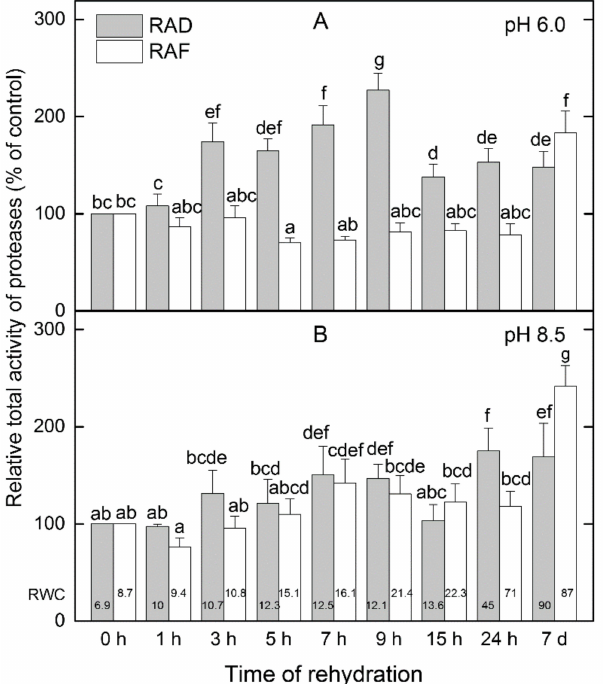
Figure 8. Relative proteolytic activity based on in-gel staining at pH 6.0 ( A ) and pH 8.5 ( B ) during the first hours of recovery of H. rhodopensis from drought- (RAD) and freezing-induced desiccation (RAF) expressed as percentage of desiccated plants (0 h). Data represent the mean of n = 3 ± SD. Changes between RAD and RAF were statistically compared. The same letters within a graph indicate no significant differences assessed by the Fisher LSD test ( p ≤ 0.05) after performing ANOVA. The RWC of plants at each time point, presented in %, are shown at the bottom of the